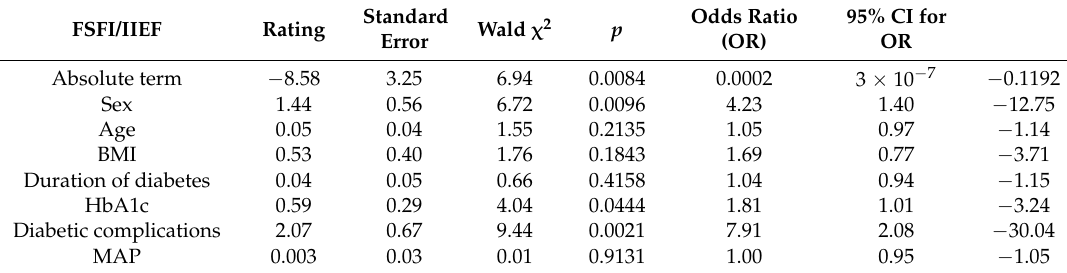
Table 7. Odds ratios and the result of Wald’s significance test obtained from the logistic regression of pathological FSFI and IIEF value occurrences in connection with sex, age, BMI, duration of diabetes, HbA1c, complications, and MAP of the